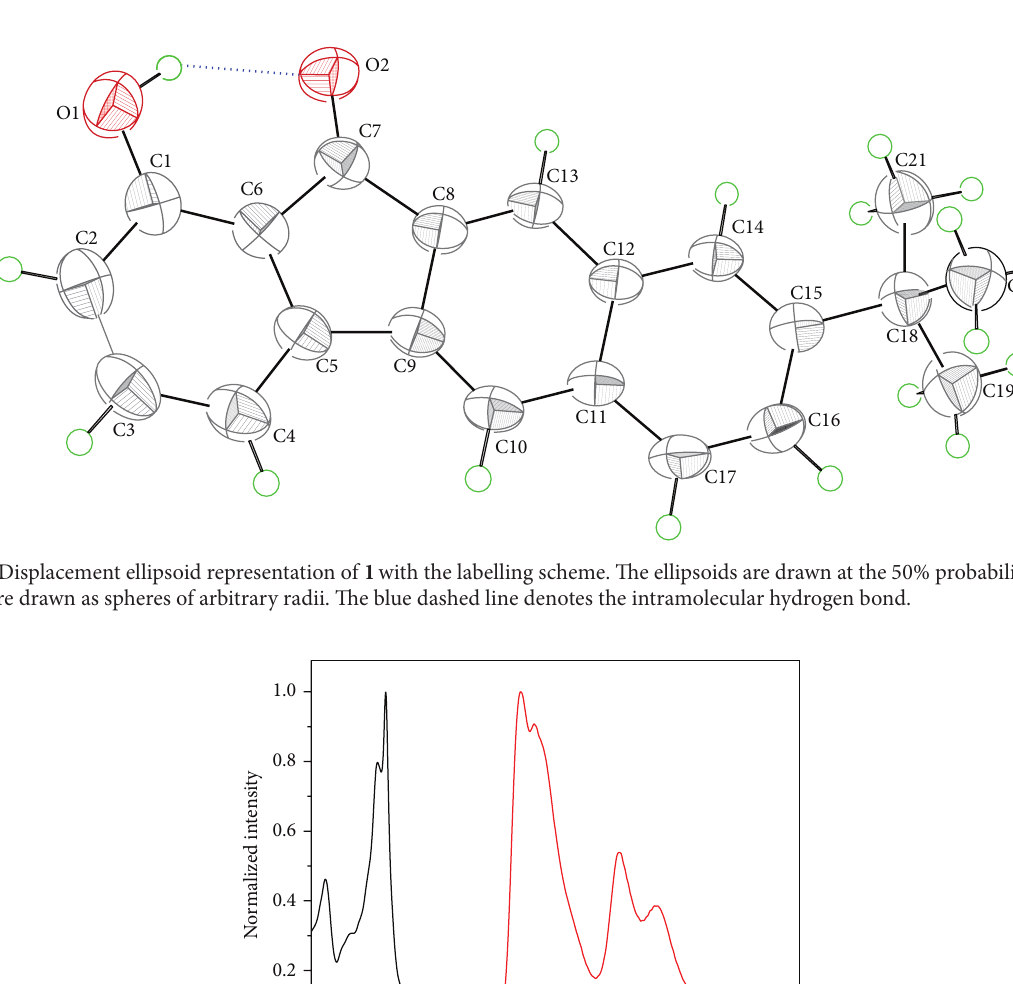
Figure 4. Incidentally, the dual emission achieves a